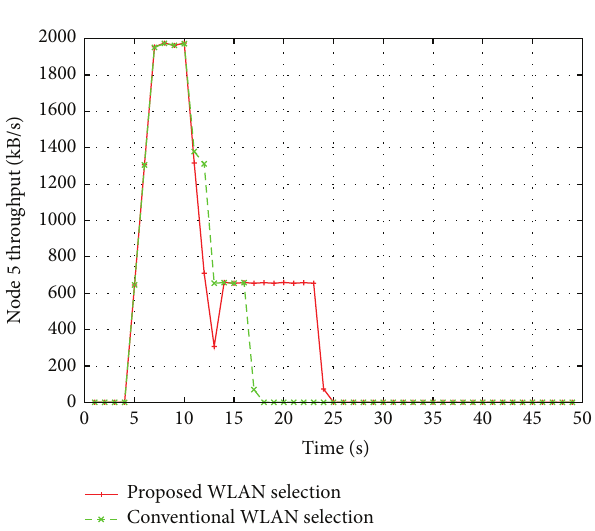
Figure 5: WiMAX BS1 (Node 5)